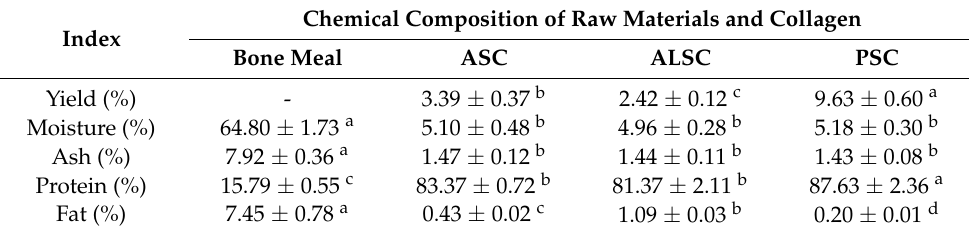
Table 1. Composition of chicken bone meal, extraction rate, and composition of collagen.